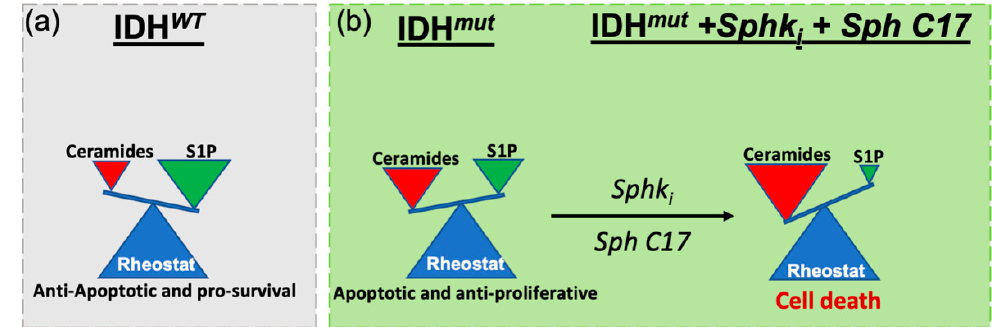
Figure 5. Proposed model for the specific IDH mut cell death induced via the modulation of cellular levels of sphingosine 1-phosphate and ceramides. ( a ) In IDH WT the ceramide to S1P rheostat is tilted towards high S1P levels which stimulate cellular signaling for anti-apoptotic and pro-survival. ( b ) IDH mut glioma present a reverse in the sphingolipid rheostat such that high ceramide and low S1P levels are present. Further exacerbation of this rheostat balance via inhibition of SphK and addition of sphingosine C17 (a reversible, immediate metabolite of ceramide) triggers cellular arrest and death in IDH mut gliomas.